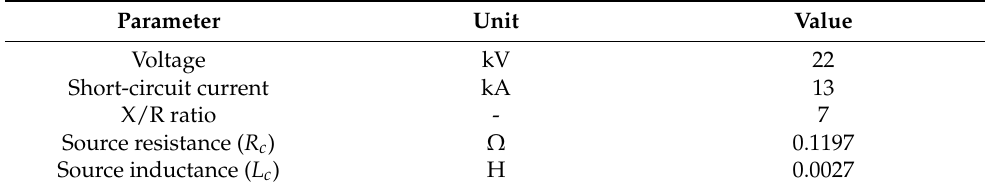
Table 1. HV source block model input values.